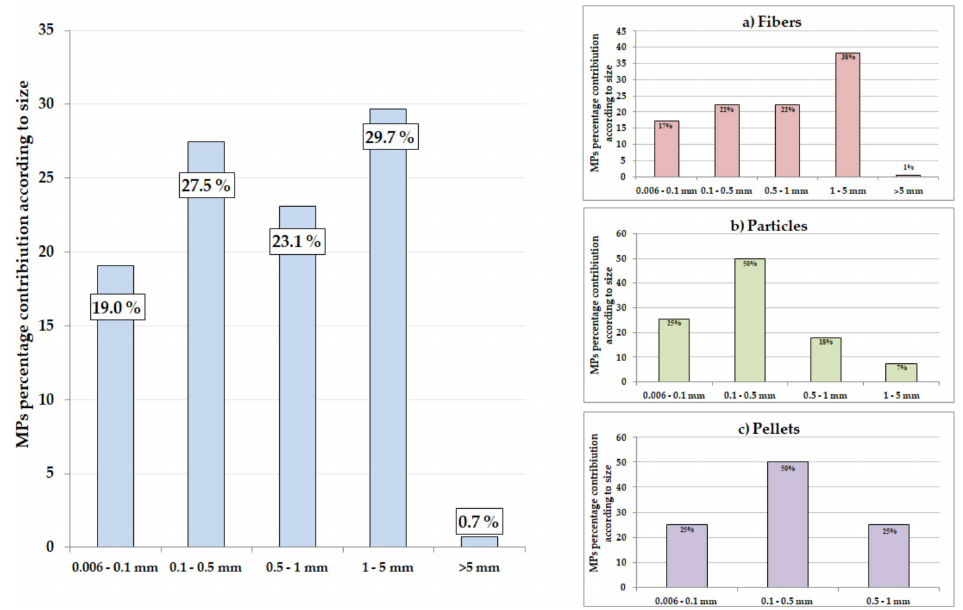
Figure 5. Categorized length dimensions for all morphological types of MPs identified in the Baltic Sea fish as well as corresponding frequency plots for fibers ( a ), particles ( b ), and pellets ( c ). The most dominant color observed was blue ( 56.0%), then black ( 13.2%), transparent (10.5%), red (9.4%), green (8.3%), white (2.3%), and yellow (0.4%). The distribution of the